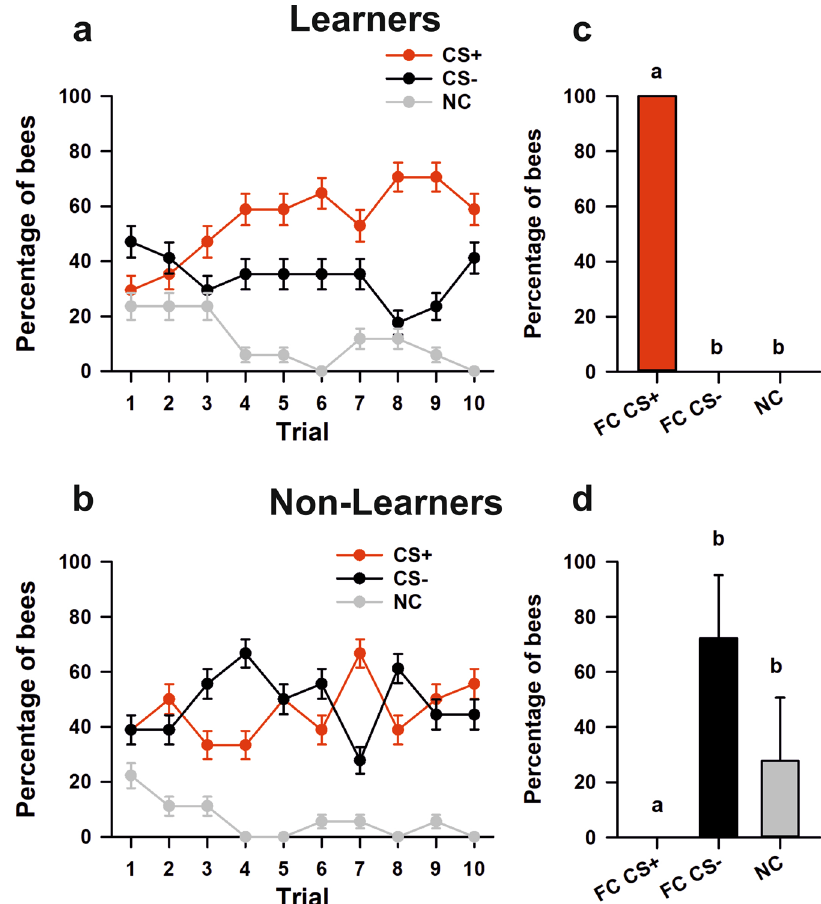
Fig. 3 Discrimination learning in the VR setup. a Acquisition performance of learners (i.e., percentage of bees that chose the CS + in the non-reinforced test; n = 17). The red, black, and gray curves show the percentages of bees choosing the CS + , the CS − or not making a choice (NC), respectively. Bees learned the discrimination between CS + and CS − . b Acquisition performance of non-learners (i.e., percentage of bees that chose the CS − or did not make a choice in the non-reinforced test; n = 18). These bees did not learn to discriminate the CS + from the CS − . c Test performances of learners. Percentage of bees choosing in their fi rst choice the CS + (FC CS + ), the CS − (FC CS − ) or not making a choice (NC). Per de fi nition, learners chose the CS + in this test. Different letters on top of bars indicate signi fi cant differences (GLMM; p < 0.05). d Test performances of non-learners. Percentage of bees choosing in their fi rst choice the CS + (FC CS + ), the CS − (FC CS − ) or not making a choice (NC). Per de fi nition, non-learners did not choose the CS + . Different letters on top of bars indicate signi fi cant differences (GLMM; p < 0.05). In all panels, error bars indicate the 95% con fi dence